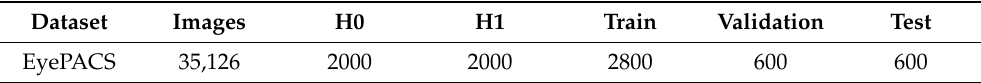
Table 6. Human opinion labeling description and hold-out strategy for training